Question: In one sentence, what is this figure communicating?
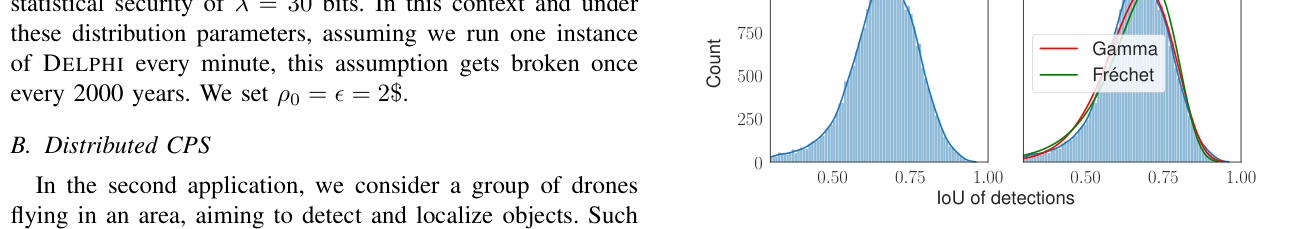
Answer: IoU histogram for Drone-based object detection: We plot the IoU values of detections output by the detection program and analyze their incidence by bucketing them into bins. These values follow a Gamma distribution, which has a thin tail.